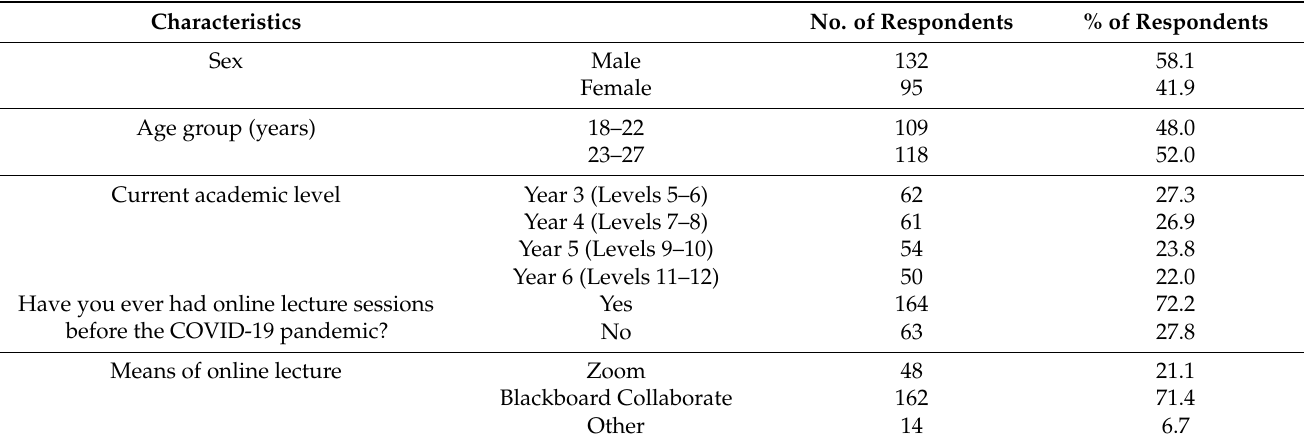
Table 1. Distribution of demographic characteristics of the